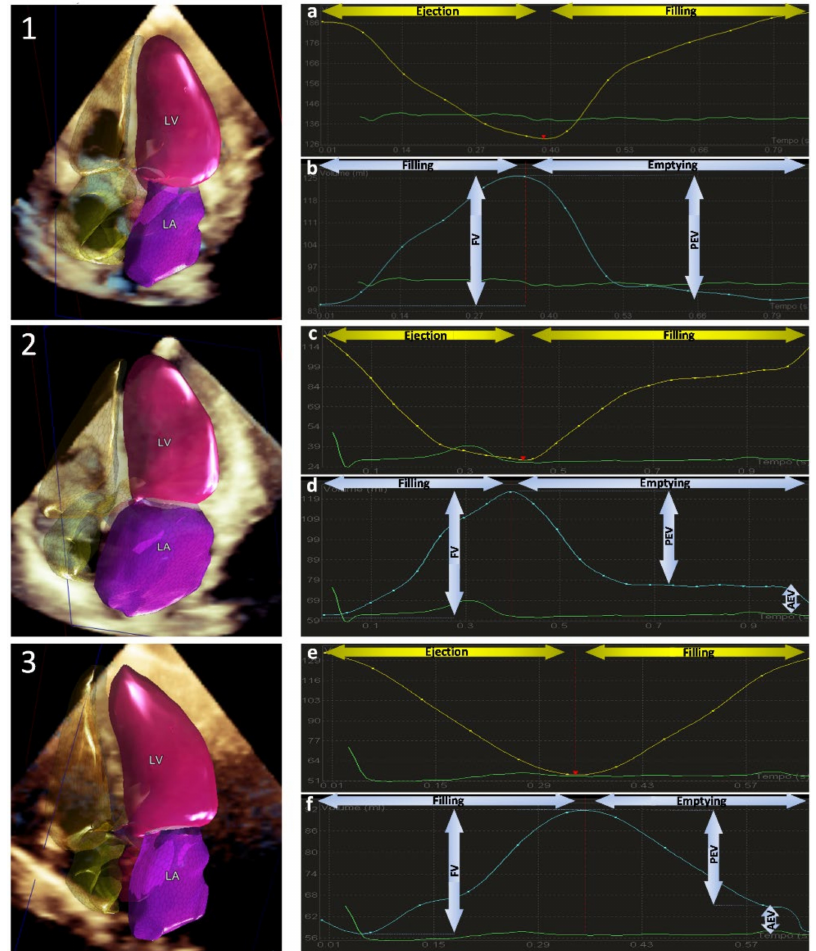
Figure 4. Analysis of left chamber volume–time curves in different pathological cases. Left panels: 3D chamber reconstructions. Right panels: LV ( top ) and LA ( bottom ) time–volume curves analysis. 1 . Atrial fibrillation: pathological absence of atrial contraction (atrial kick) is observed in both LV and LA time–volume panels ( a , b ). 2 . Severe mitral regurgitation: a consistent LA enlargement is clearly identified in the software reconstruction; LV maintains a preserved stroke volume with rapid ejection time ( c ); the enlarged atrium preserves its emptying properties, as sinus rhythm is guaranteed ( d ). 3 . Severe aortic stenosis: late systolic peak of LV curve is well represented ( e ); prolonged atrial passive emptying is observed as a result of marked increase in LV pressure ( f ). LA = left atrium; LV = left ventricle; FV = filling volume; PEV = passive emptying volume; AEV = active emptying